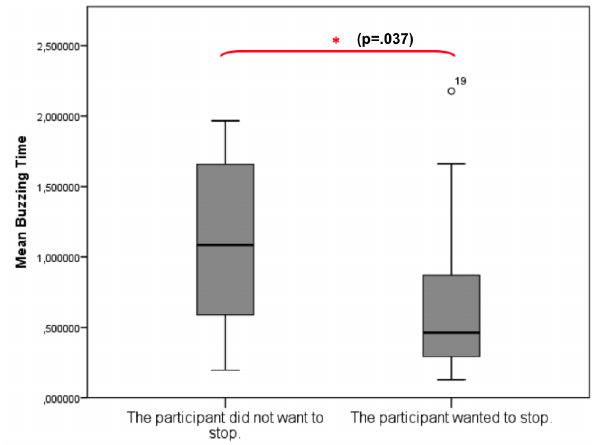
Figure 12: Difference in the mean buzzing time in seconds against the participant’s reported desire to abandon the